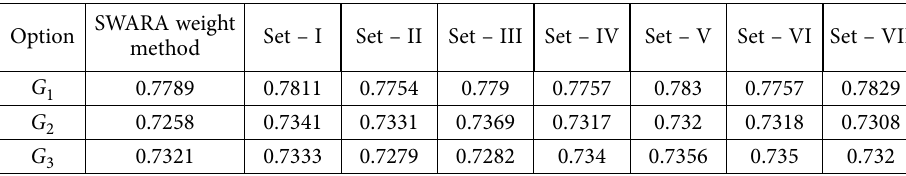
Table 11. Utility degree of organizations with different weight sets SWARA weight Option